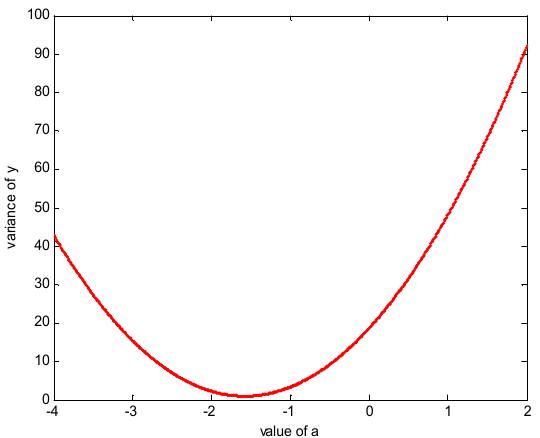
Figure 11. The variance of difference between s and f under different value of a. Appl. Sci. 2016 , 6 , 396